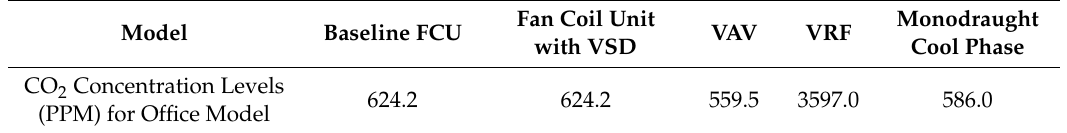
Table 15. Average CO 2 Concentration level for different cooling systems.